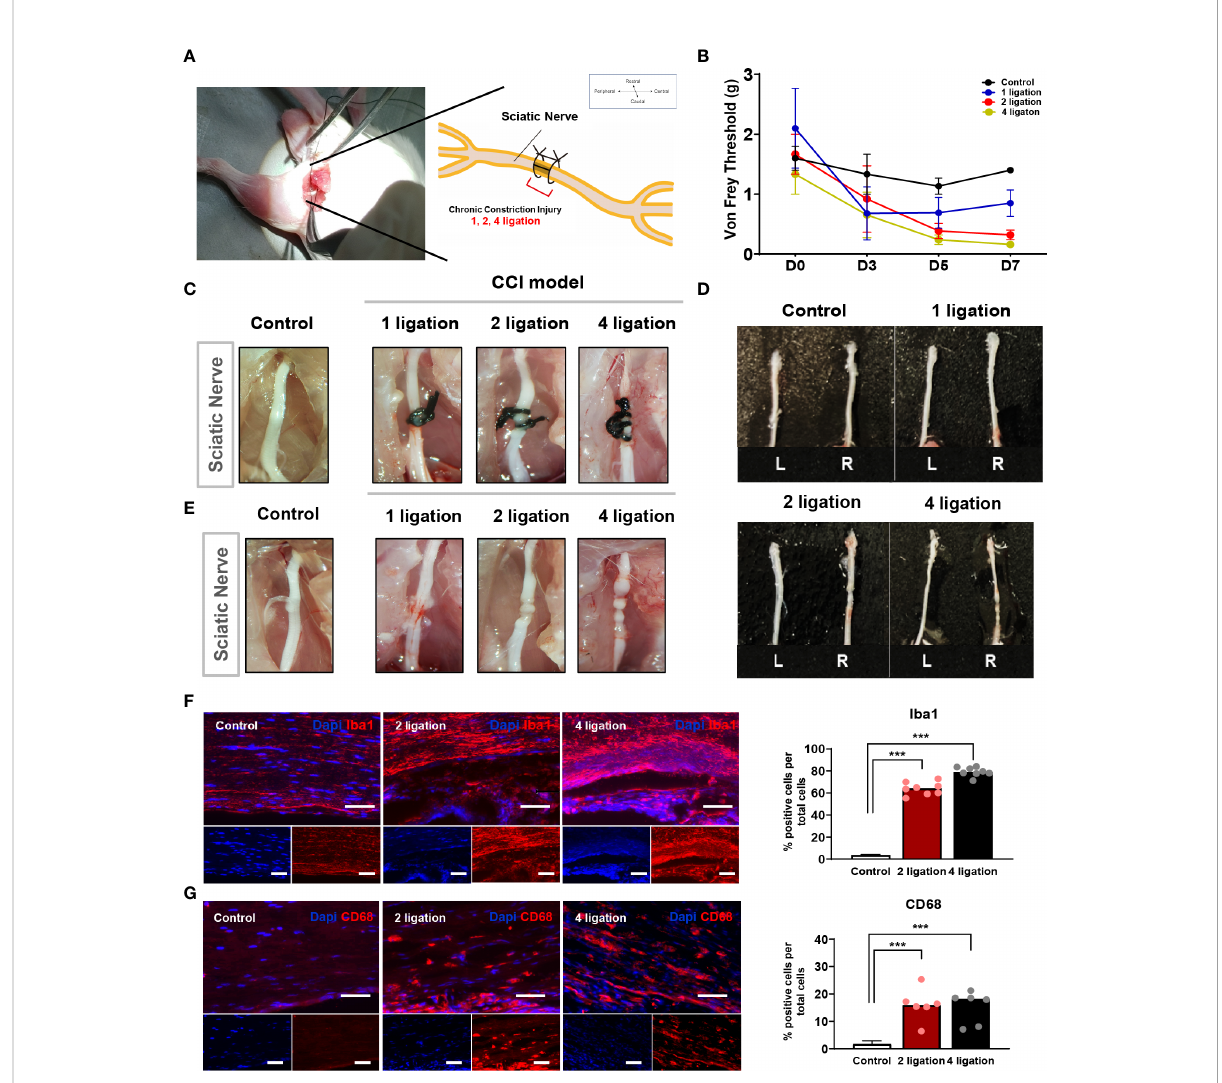
FIGURE 1 Induction of chronic constriction injury mouse model and in fl ammatory factors. (A) The location of ligation knots on the right hindlimb sciatic nerve. (B) Von Frey test of 1, 2, 4 ligations CCI mouse model. Day 0 is baseline threshold before the injury (n = 5 mice for each group). Morphological features of (D) sciatic nerve (C) before and (E) after ligations. (F) Immuno fl uorescence staining of Iba-1 positive cells (Red) with DAPI (Blue). Percentage of Iba-1 positive cells in 2 and 4 ligations CCI model. Scale bar: 150 m m. (G) Immuno fl uorescence staining of CD68- positive cells (Red) and DAPI (Blue). Percentage of CD68-positive cells in 2 and 4 ligations compared to control. Scale bar: 150 m m. Data are presented as mean ± SEM. Statistical differences were analyzed using one-way ANOVA, followed by Tukey ’ s post hoc test, *** p <